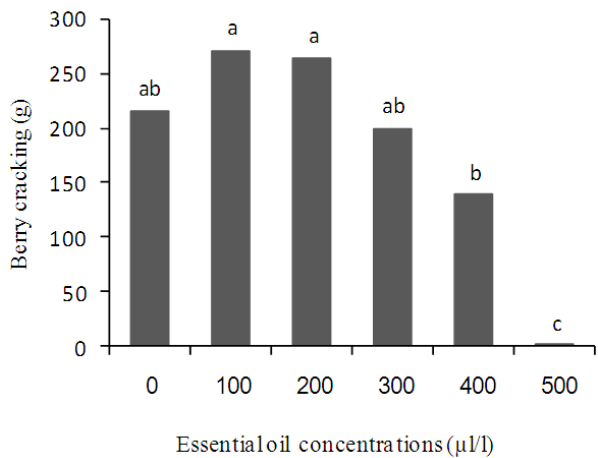
Fig. 10. The effect of essential oil treatment on berry cracking